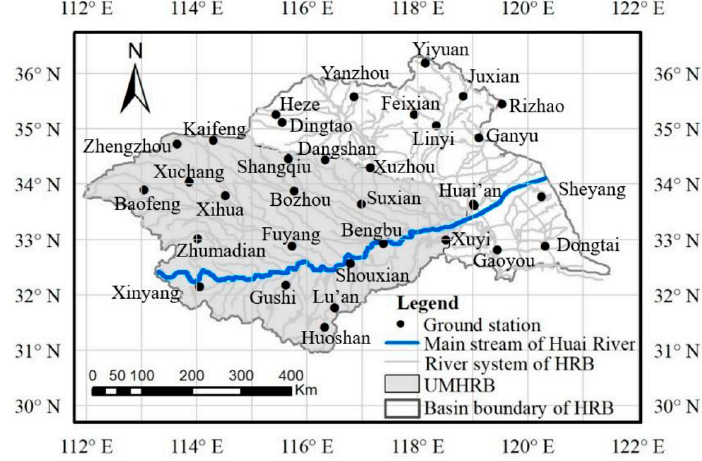
Figure 1. Location of the upper and middle reaches of the Huai River Basin and the distribution of ground meteorological stations.